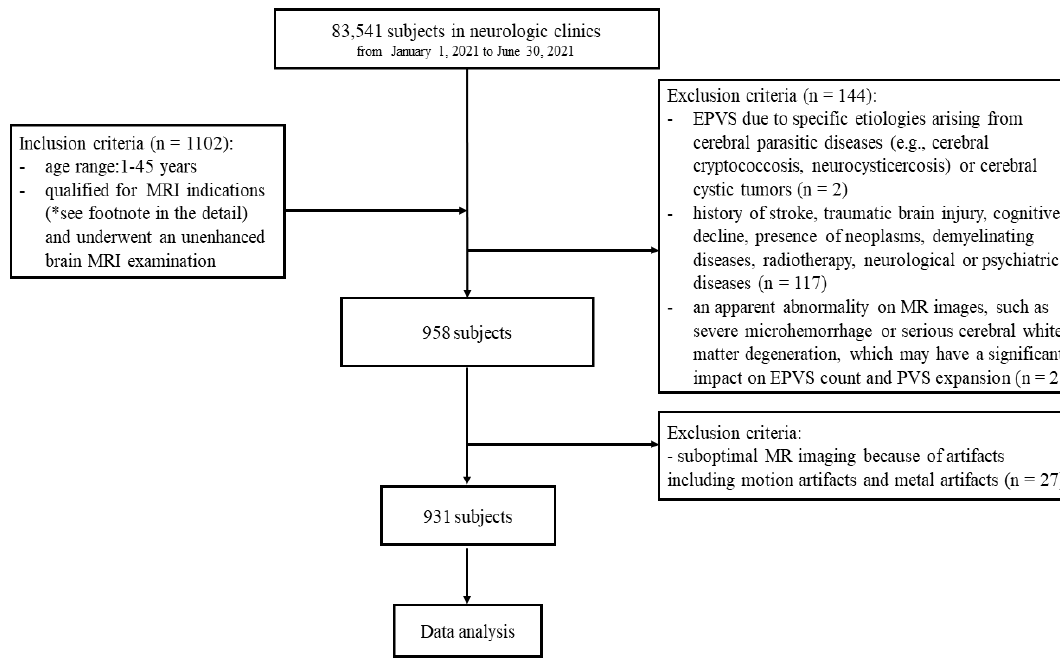
Figure 1. Subject screening workflow. *, MRI indications were defined as follows: (1) an increase in the frequency and severity of symptoms, such as headache, which may indicate secondary pathol- ogy ( n = 797); (2) any abnormal neurologic finding, including asymmetric or unilateral hearing or vision loss ( n = 238); and (3) no neurologic symptoms, with head examinations as part of physical examination ( n =